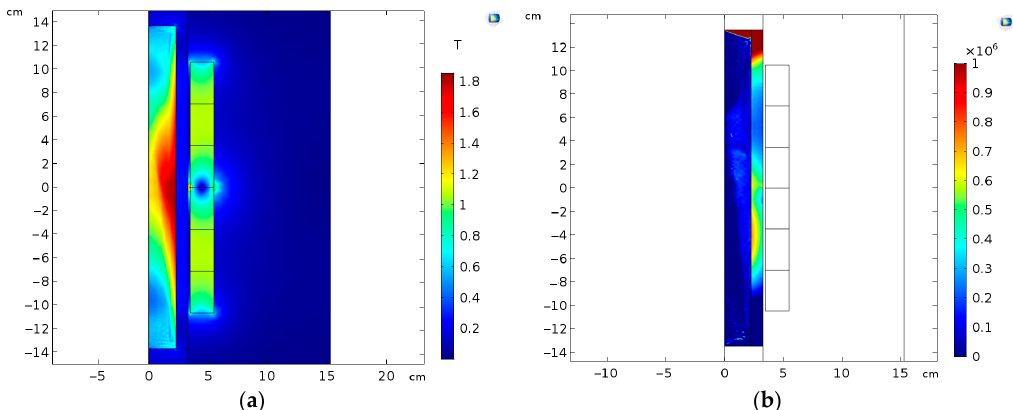
Figure 5. For Model II: ( a ) Magnetic flux density, ( b ) induced current density, at v = 1.0 m/s.